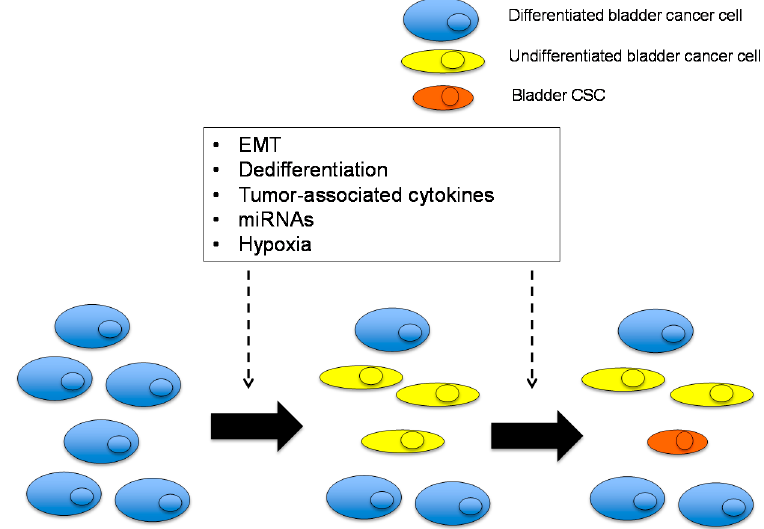
Figure 3. Possible mechanisms of bladder CSC generation from more differentiated bladder cancer (BC) cells. Differentiated and undifferentiated BC cells, which are defined as non-CSCs, are a possible origin of bladder CSCs. This phenomenon is caused by cell-autonomous mechanisms and the tumor microenvironment, including epithelial-mesenchymal transition (EMT), dedifferentiation, tumor-associated cytokines, miRNAs, and hypoxia.